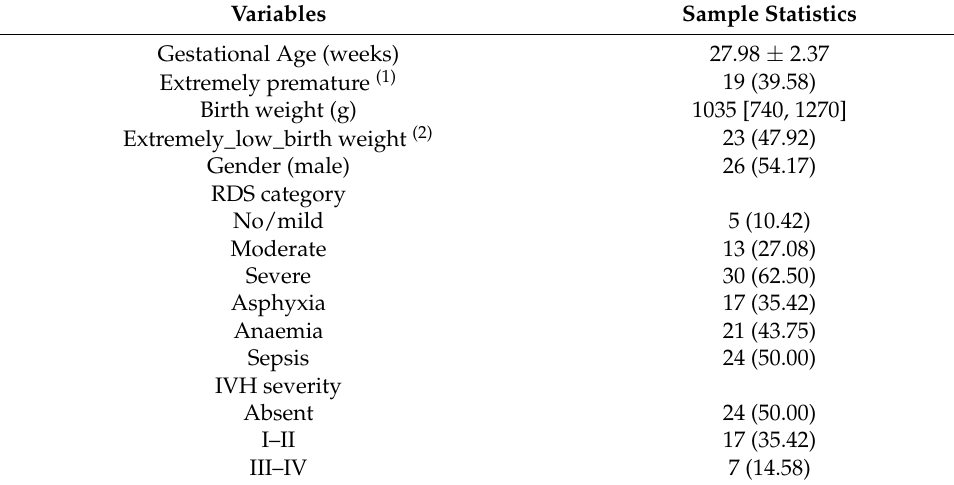
Table 1. Characteristics of the premature neonate group.